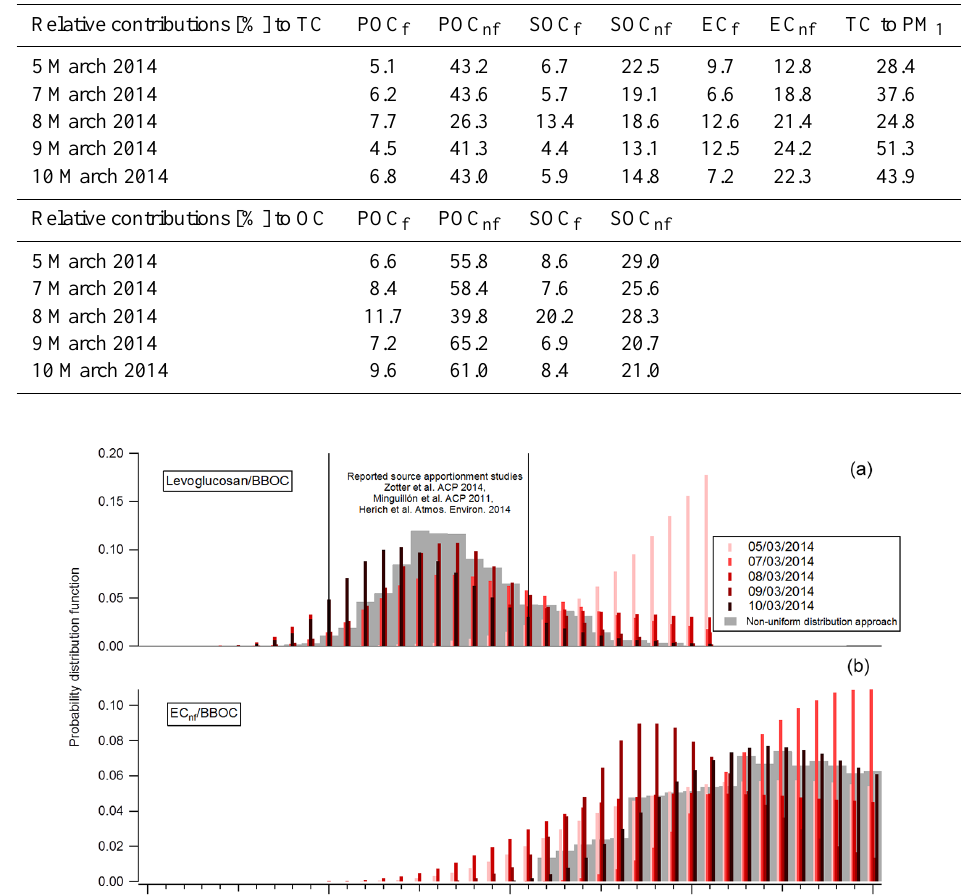
Table 3. Average percentage contributions of different sources.